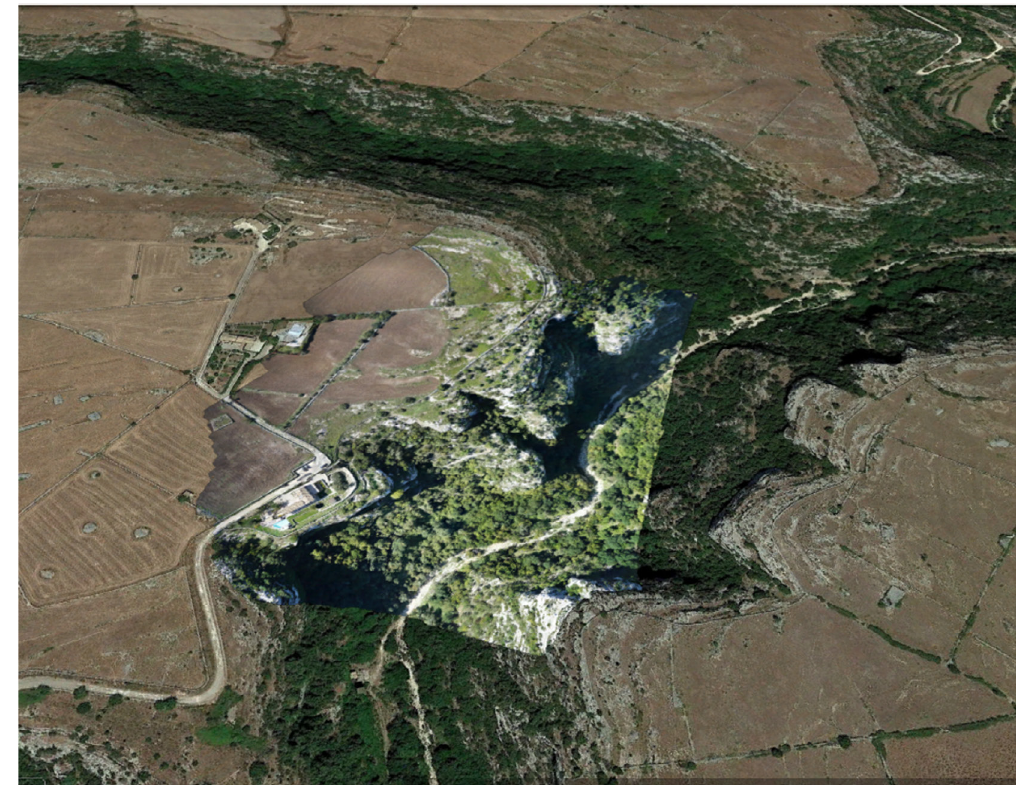
Figure 11. The gorge of Calicantone. The 3D georeferenced model (KMZ file) overlaid on Google